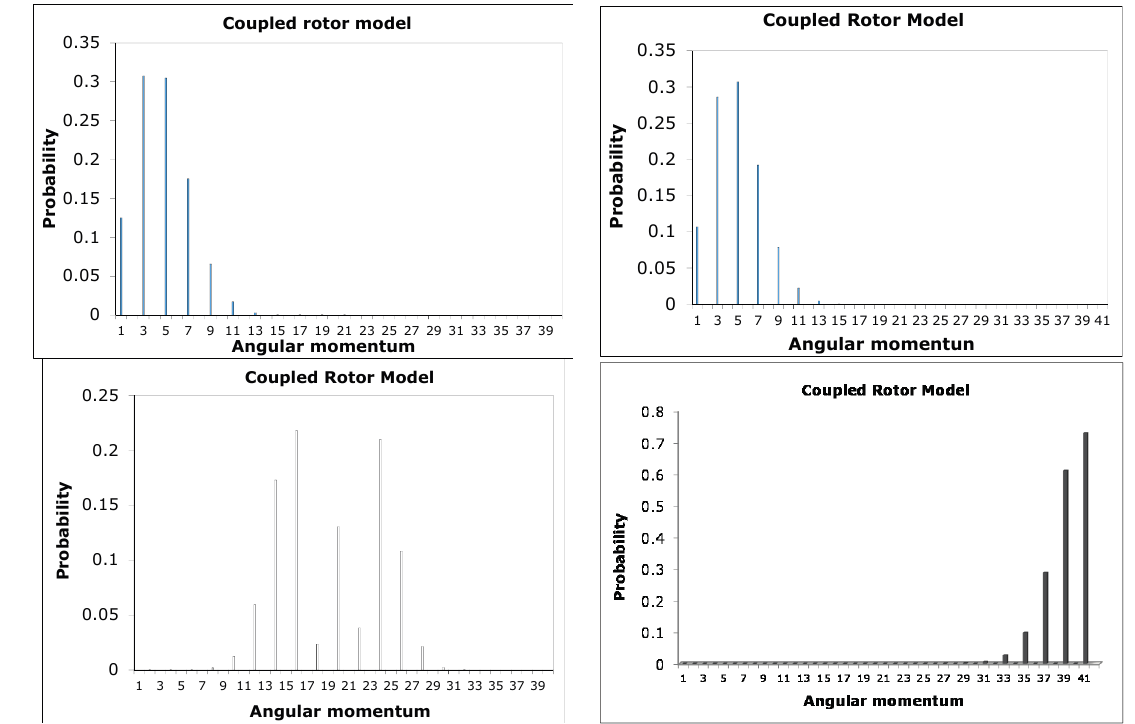
Figure 13. Probability distribution at J = 0 for a particle constrained for two coupled rotors ℓ = 0 − 40